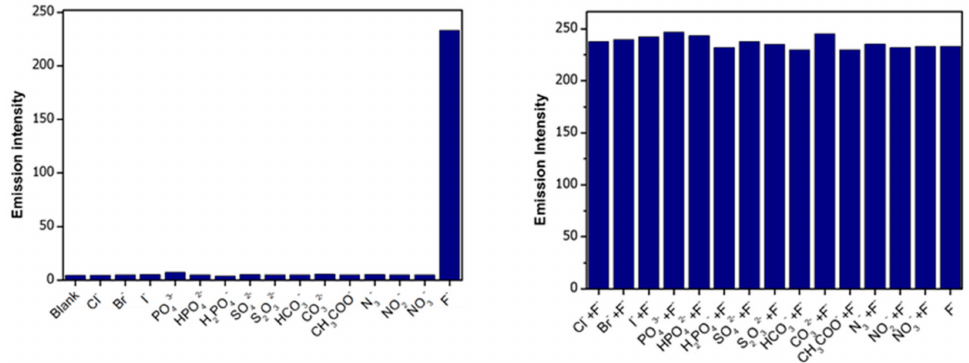
Figure 7. ( Left ) Bar chart demonstrating fluorescence intensities at 473 nm for 5 (2 µ M) in the presence of different anions (1 mM). The fluorescence spectra corresponding to this chart are displayed in Figure S27. ( Right ) Bar chart demonstrating fluorescence intensities at 473 nm for 5 (2 µ M) in the presence of fluoride (1 mM) co-existing with other anions (1 mM). The fluorescence spectra corresponding to this chart are displayed in Figure S28.